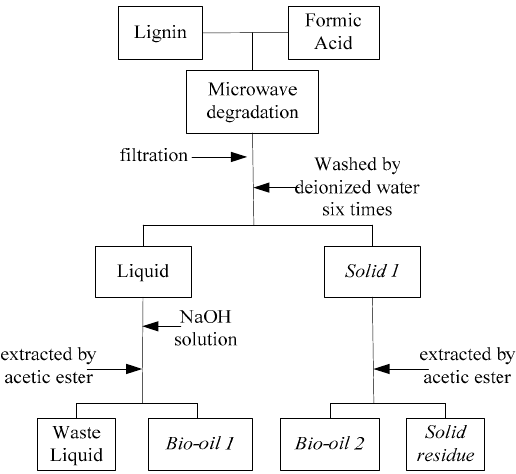
Figure 5. Schematics for the experimental process.